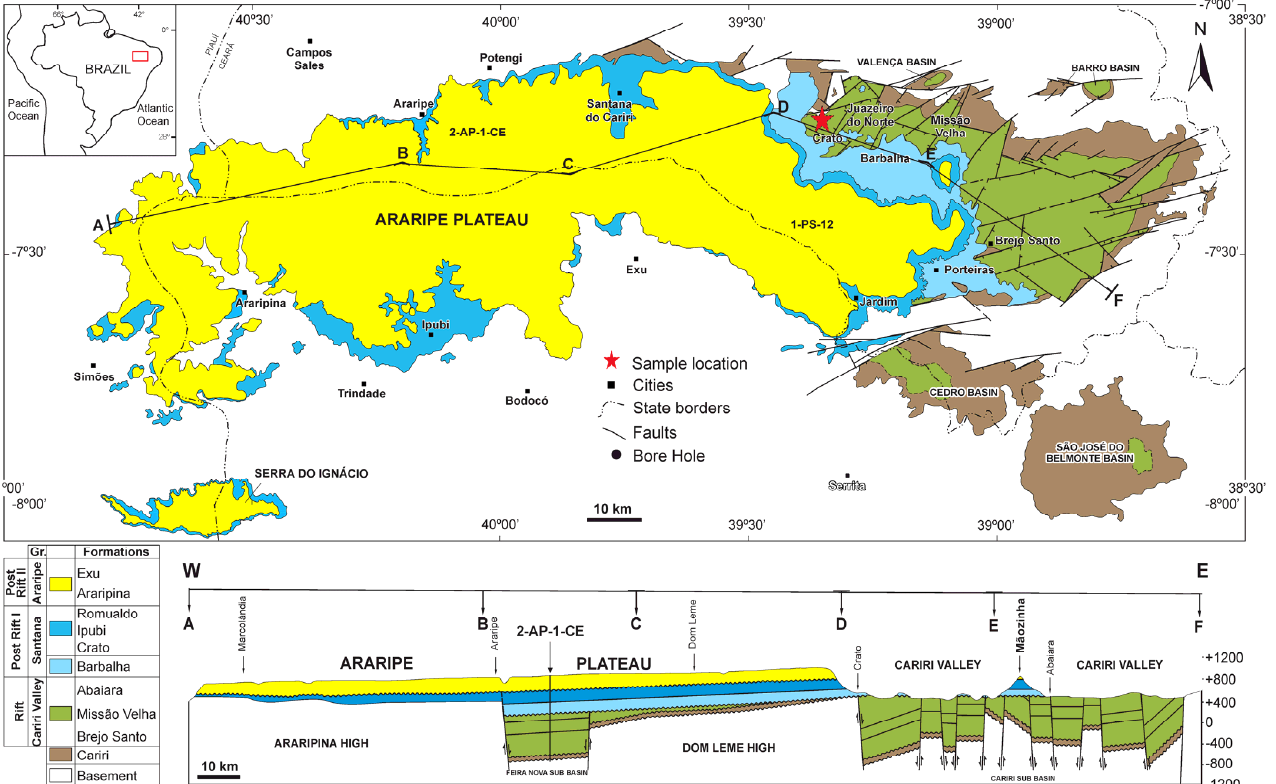
Figure 3. Geological map of Araripe basin. The red star indicates the sample location where the exemplars were collected.